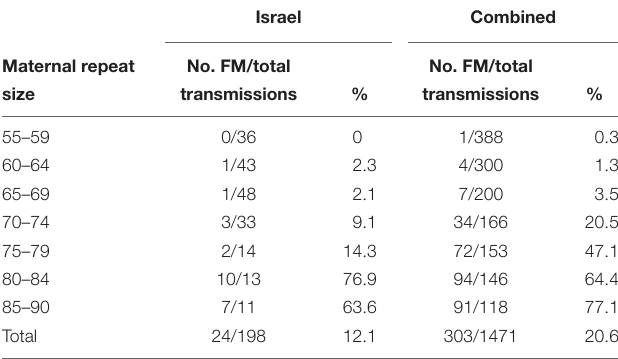
TABLE 1 | The risk of full mutation (FM) expansion by maternal CGG repeat